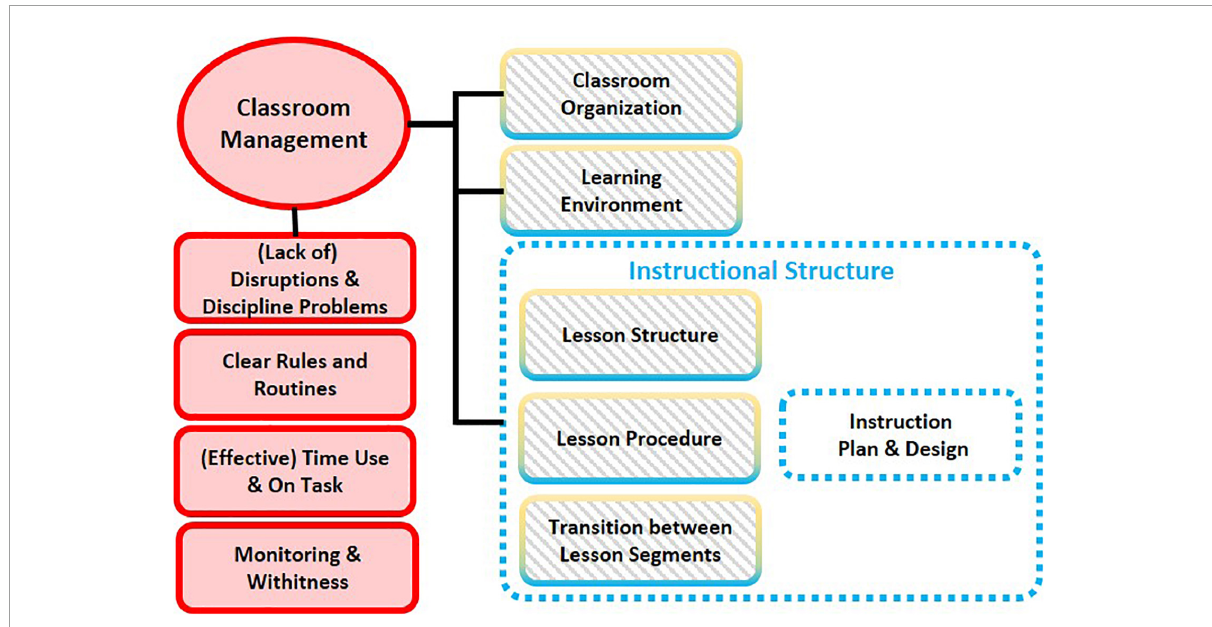
FIGURE3 Suggested adjustments on the measurement framework of Classroom Management according to the comparison between conceptual indicators and empirical measurement dimensions.